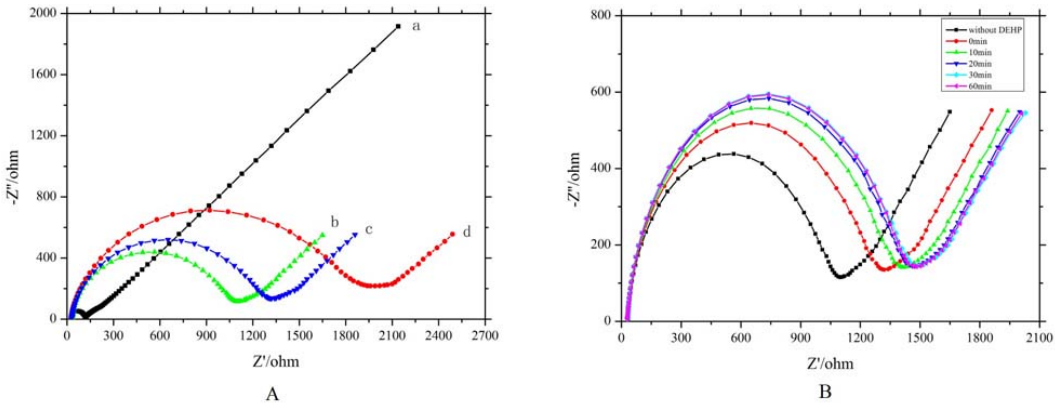
Figure 5. Electrochemical impedance spectroscopy (EIS) aptasensor. ( A ) Behavior of EIS aptasensor: (a) bare AuE, (b) aptamer 31 anchored on the gold electrode surface, (c) incubated with MCH, (d) incubated with DEHP. ( B ) Optimization of the incubation time between DEHP and aptamer.